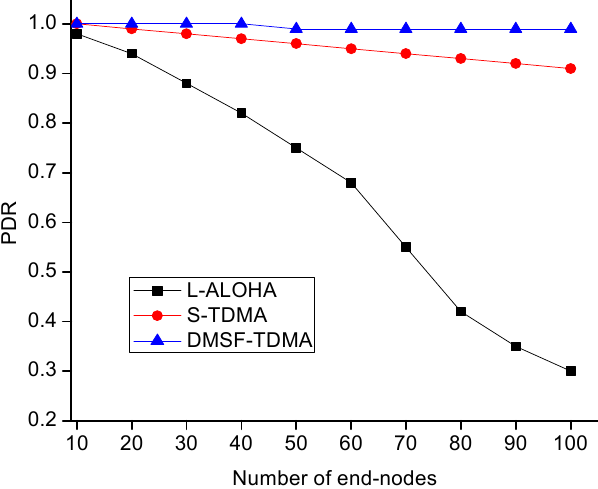
Figure 17. Average PDR with a different number of end-nodes.